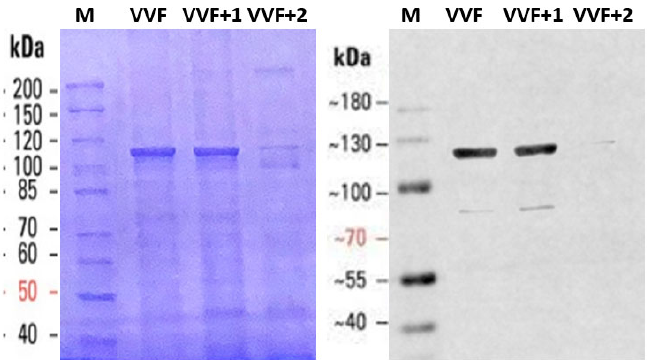
Figure 2. SDS-PAGE (8% gel) of vault eluted from the SEC column. The void volume fraction (VVF) and the following ones (VVF+1 and VVF+2) were subjected to electrophoresis, Coomassie stained (left panel) and Western blotted (right panel). M: standard proteins with the respective molecular weights (kDa). Other details are reported in Materials and Methods (Section 4.6).